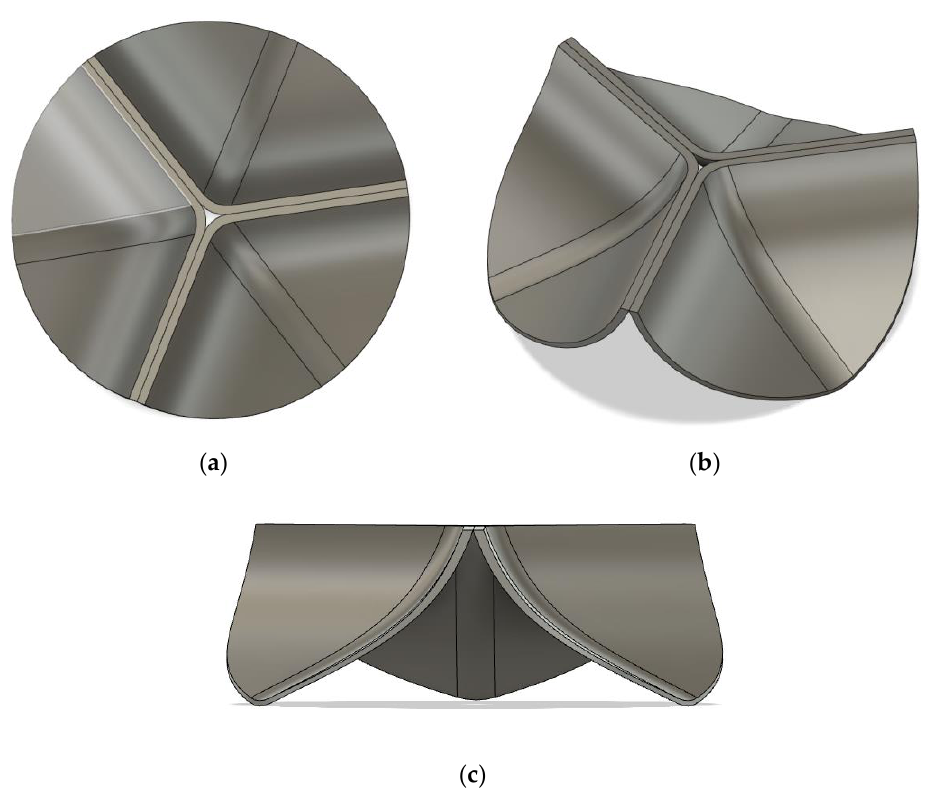
Figure 1. External appearances of artificial human heart valve with asymmetric tri-leaflet. ( a ) Top view, ( b ) Isometric view, and ( c ) Side view.